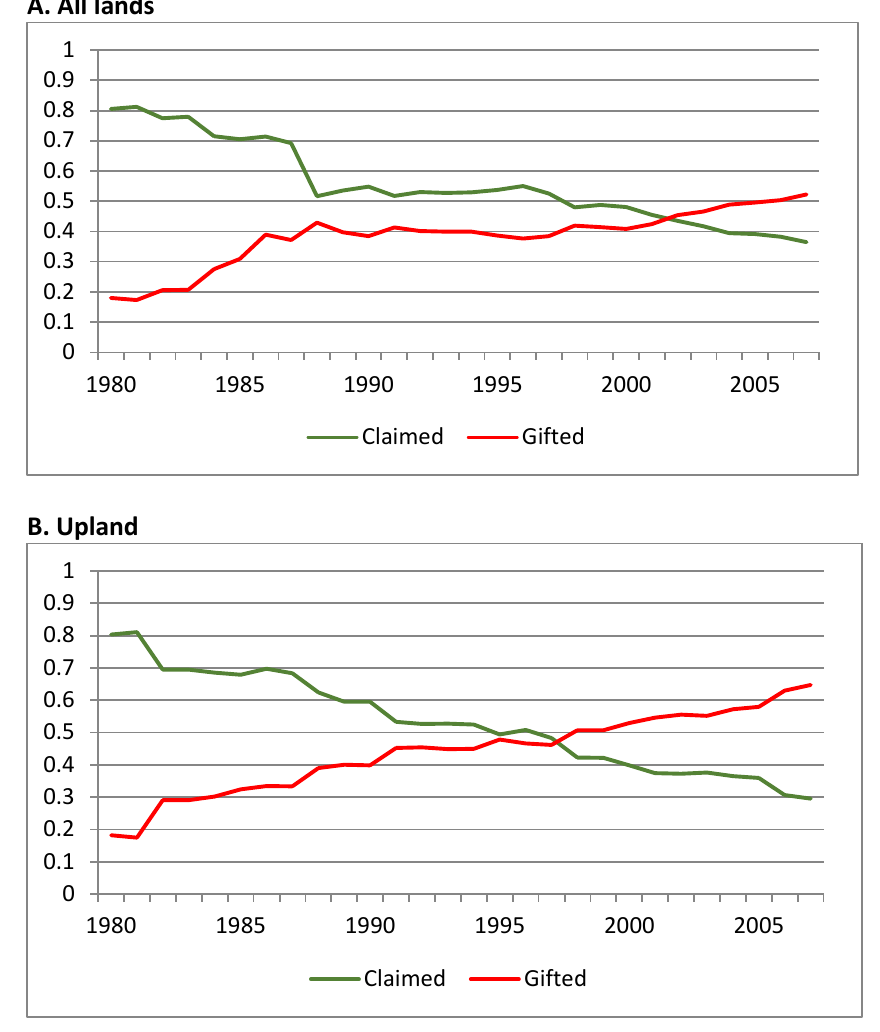
Figure A1.1. Gini decomposition by mode of land acquisition for all lands (A) and upland only (B), 1980-